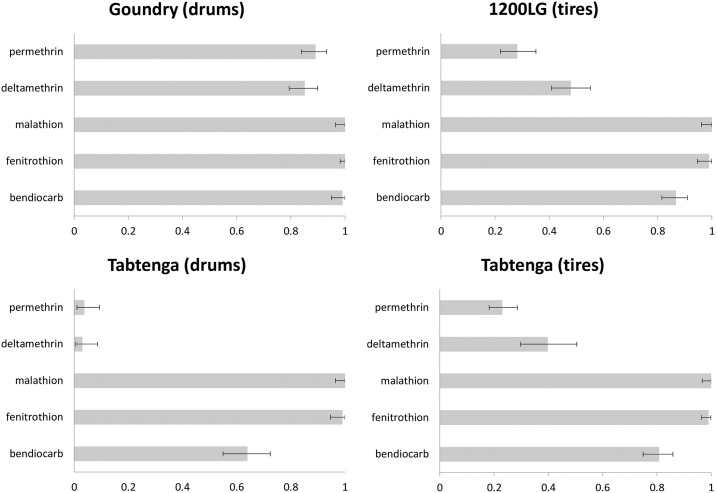
WHO 1h tube bioassay mortality (x-axis) from each site, with breeding site type indicated.Error bars show 95% binomial confidence intervals.